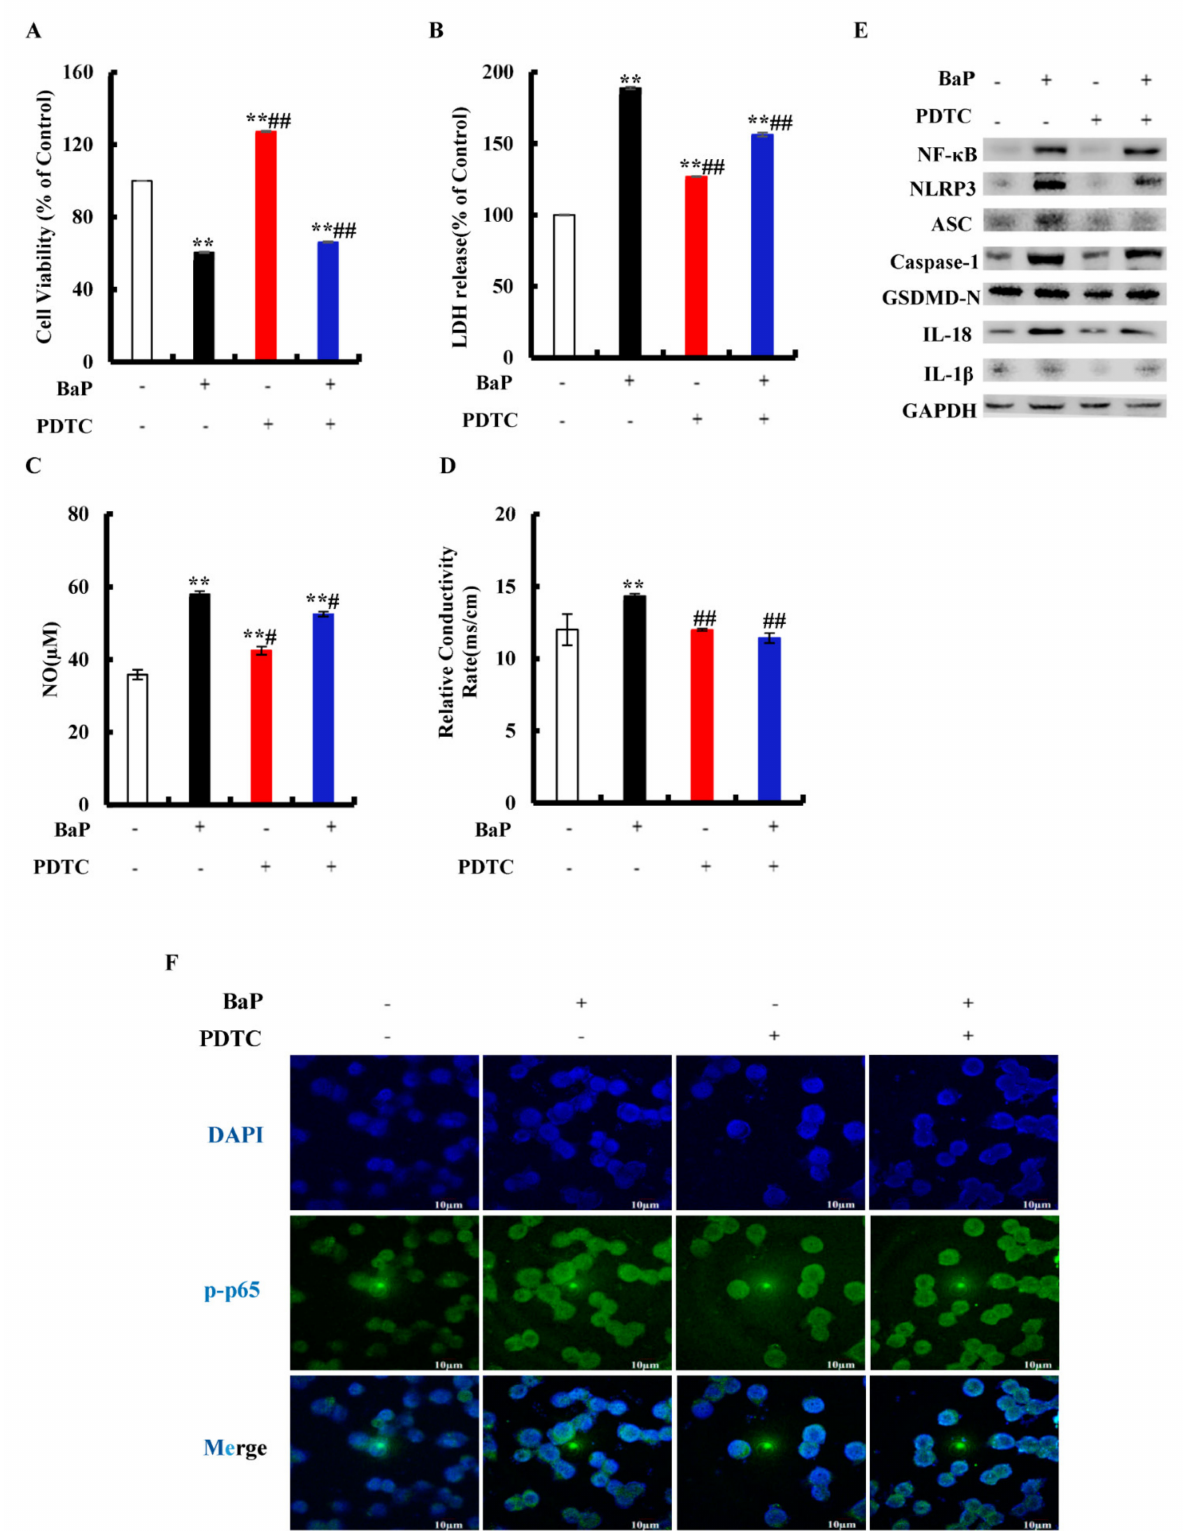
Figure 5. Effects of NF- κ B inhibitor (PDTC, 50 µ M) on pyroptotic hepatocyte damage induced by BaP (25 µ M). Cell viability ( A ), LDH ( B ), NO ( C ), and electrical conductivity ( D ) were detected. ** p < 0.01 compared with control, ## p < 0.01 compared with 25 µ M BaP. Western blot image of protein expression acquired by Chemical XRS Imaging System ( E ). Nuclear translocation of phosphorylated p65 was observed by immunofluorescent labeling with DAPI (blue) and anti- phosphorylated p65 (green) ( F